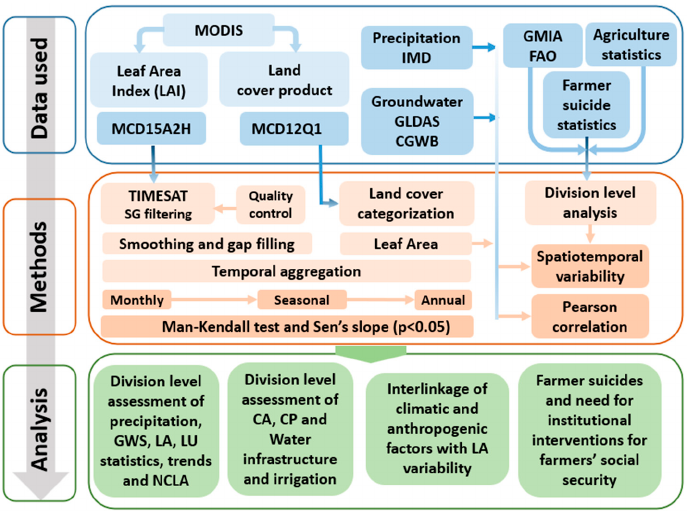
Figure 2. Schematic of various data sources, methods, and analysis carried out in this